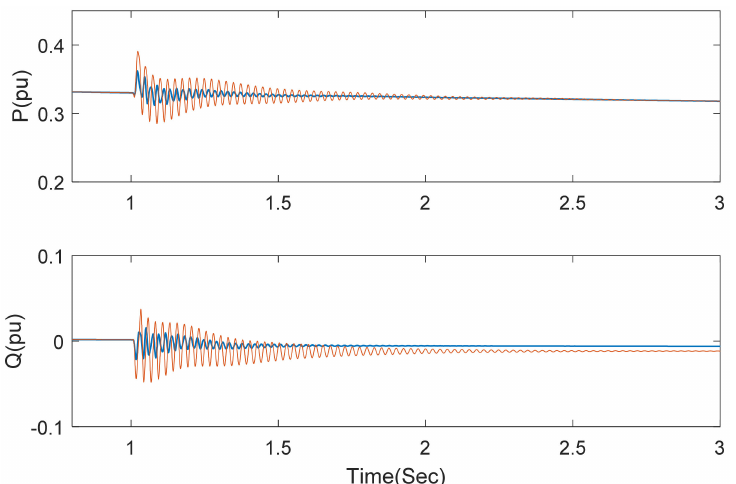
Figure 12. Active responses under the proposed method (blue) and partial feedback linearity (red) with wind speed of 6 m/s and compensation of 60%.